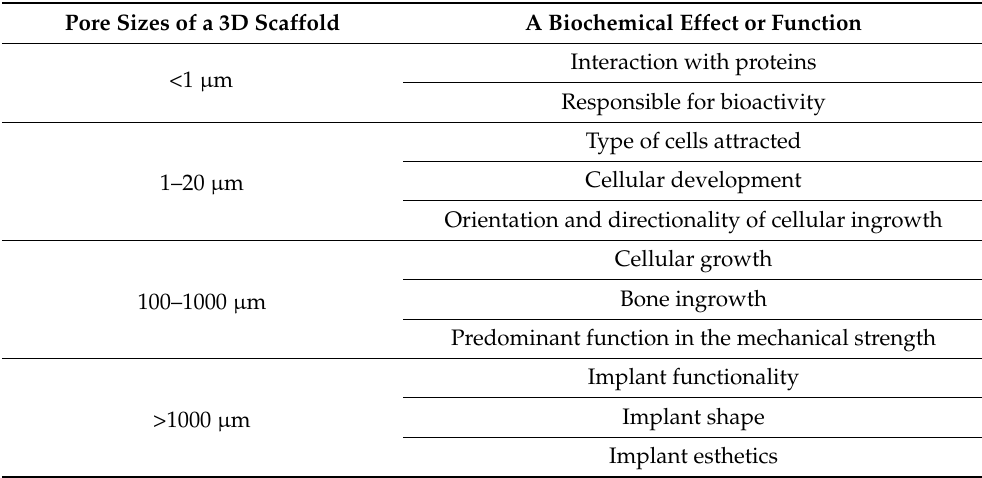
Table 4. A hierarchical pore size distribution that an ideal scaffold should exhibit [797].